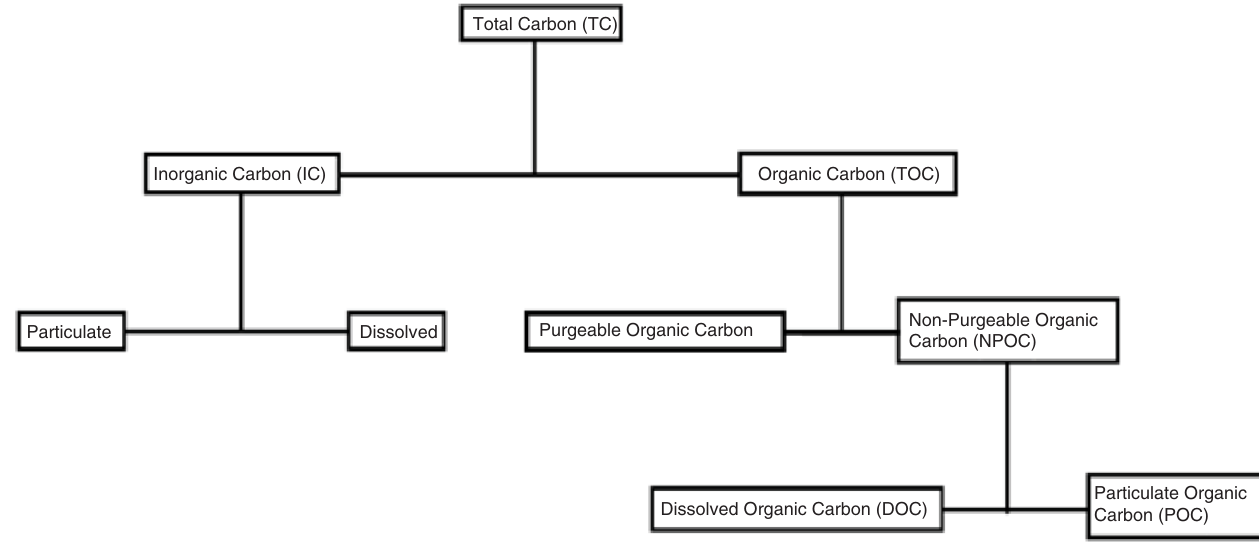
Figure 2. Flow chart showing ingredient components of total carbon.